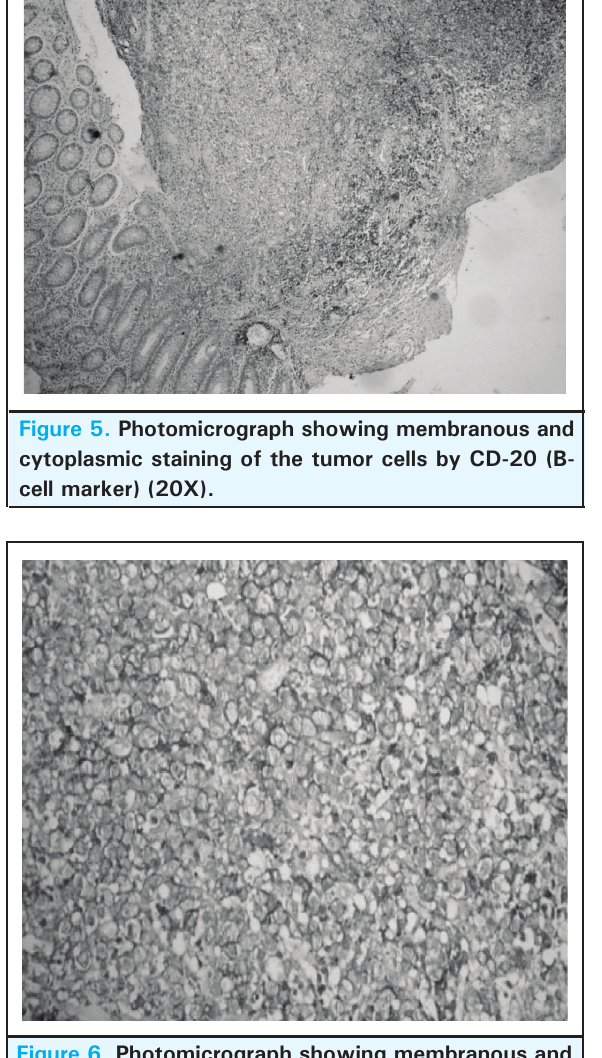
Figure 6. Photomicrograph showing membranous and cytoplasmic staining of the tumor cells by CD-20 (B- cell marker)